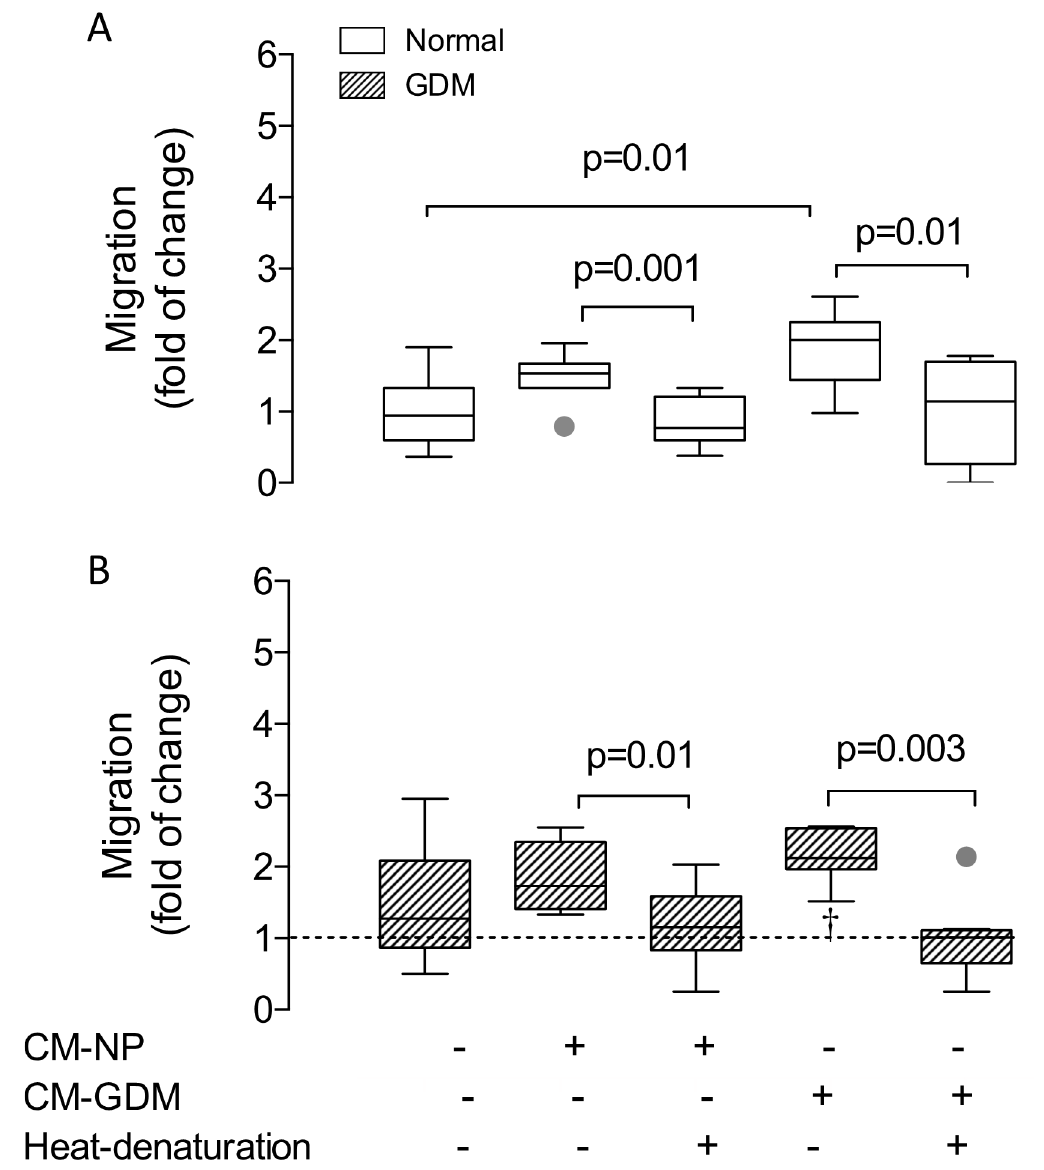
Fig 7. Cell migration in fetal endothelium from gestational diabetes mellitus. A) Cell migration (8 h) of HUVEC isolatedfrom normal(Normal, white bar) or B) gestational diabetesmellitus (GDM, hatchedbar) pregnanciesexposed to conditionedmedium harvestedfrom cell cultures of either normal (CM-NP, +) or gestational diabetes mellitus (CM-GDM, +) pregnancies,or respectiveheat denaturizedconditioned medium (heat denaturation). Representative images are available upon request. n = 4 in each group. Significant differences are indicatedwith respectiveP value. In B, line represents basal value in normal pregnancy. †P < 0.05vs HUVEC from normal pregnancy cultured in